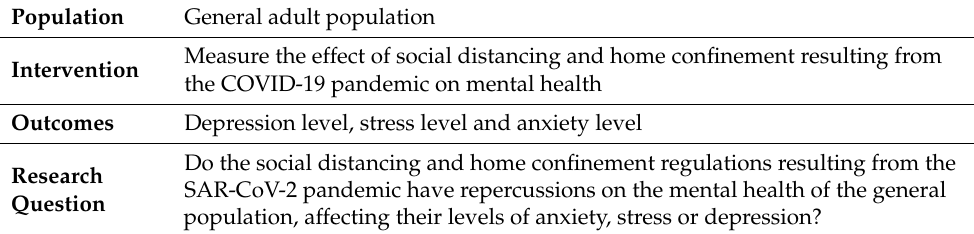
Table 1. PIO format: